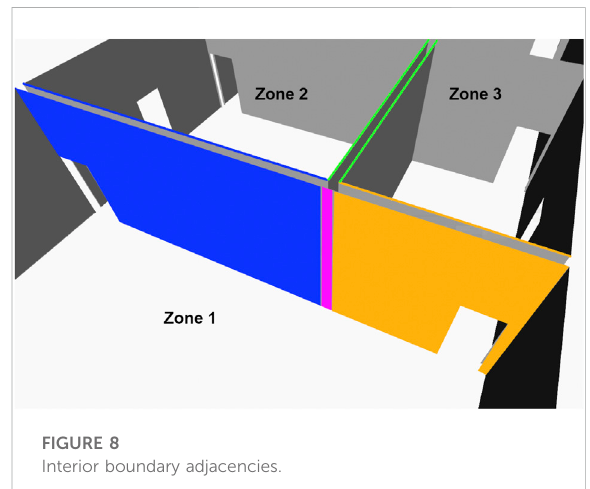
FIGURE 8 Interior boundary